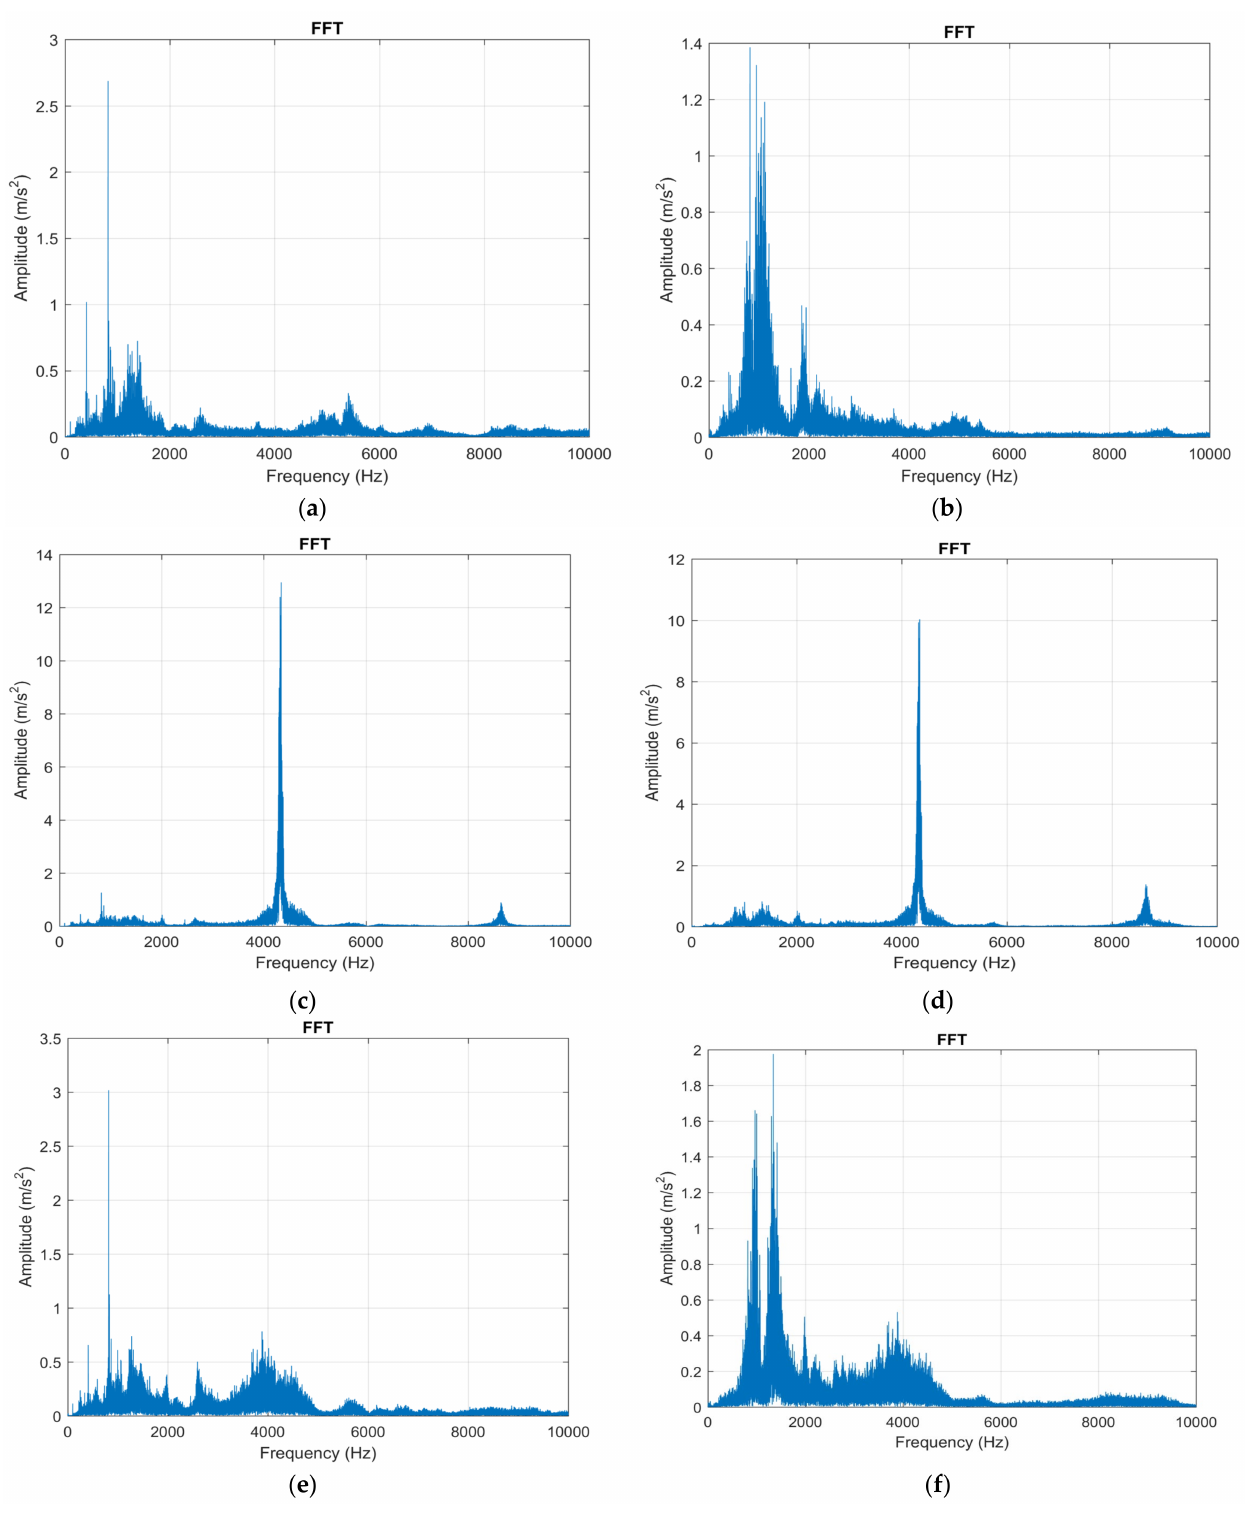
Figure 7. Vibration analysis by applying FFT: ( a ) in the Z direction in the case of machining with a cutting tool T01; ( b ) in the X direction in the case of machining with a cutting tool T01; ( c ) in the Z direction in the case of machining with a cutting tool T02; ( d ) in the X direction in the case of machining with a T02 cutting tool; ( e ) in the Z direction in the case of machining with a T03 cutting tool; ( f ) in the X direction in the case of machining with a T03 cutting